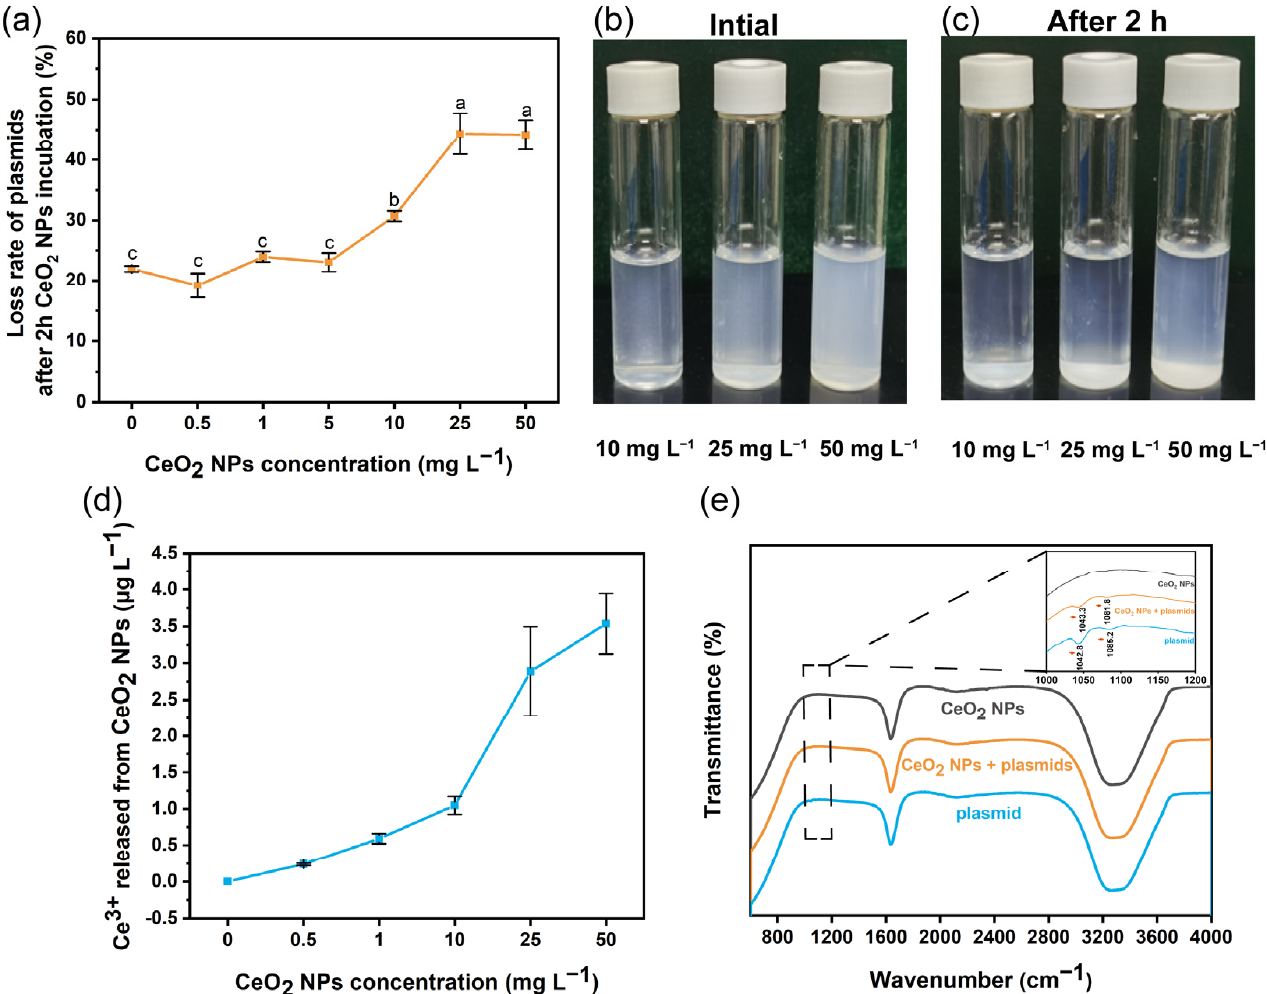
Figure 3. Interactions between plasmids and CeO 2 NPs. Loss rate of pAC plasmids after incubation with CeO 2 NPs for 2 h ( a ). Images of CeO 2 NPs self-aggregation at 10, 25, and 50 mg L − 1 for 2 h ( b , c ). Dissolution of CeO 2 NPs ( d ). Comparison of FTIR spectra of pAC plasmids before and after incubation with CeO 2 NPs ( e ). Lowercase letters represent the statistical significance among different concentrations of CeO 2 NPs.